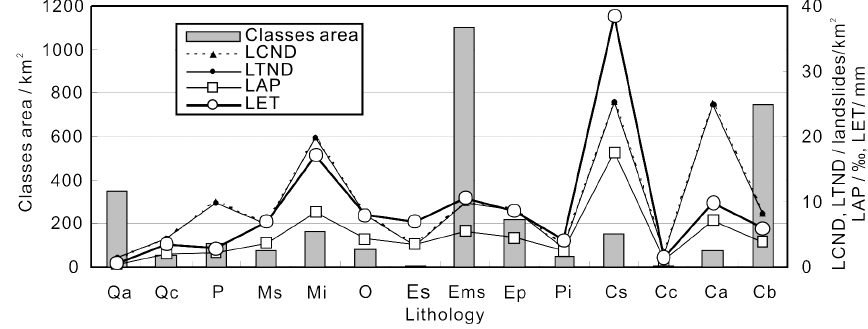
Figure 21. Relationships of landslide proxies with lithology.